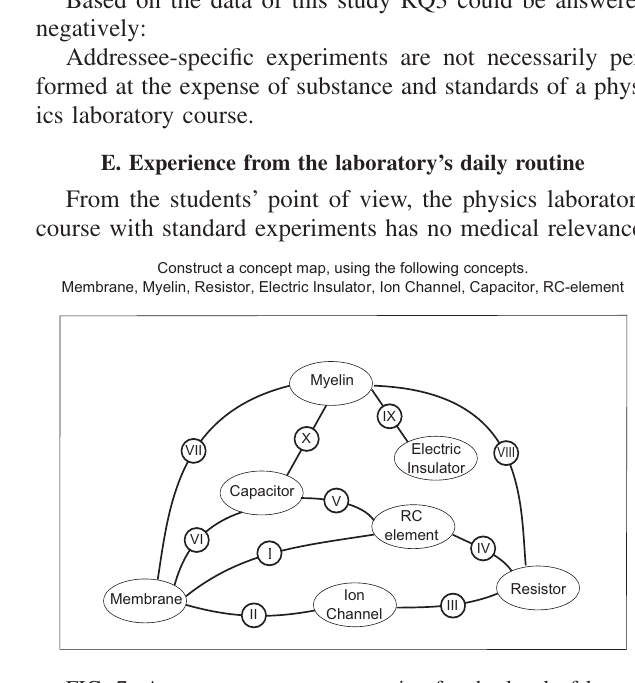
Table VIII (cid:2) is necessary to answer RQ3.